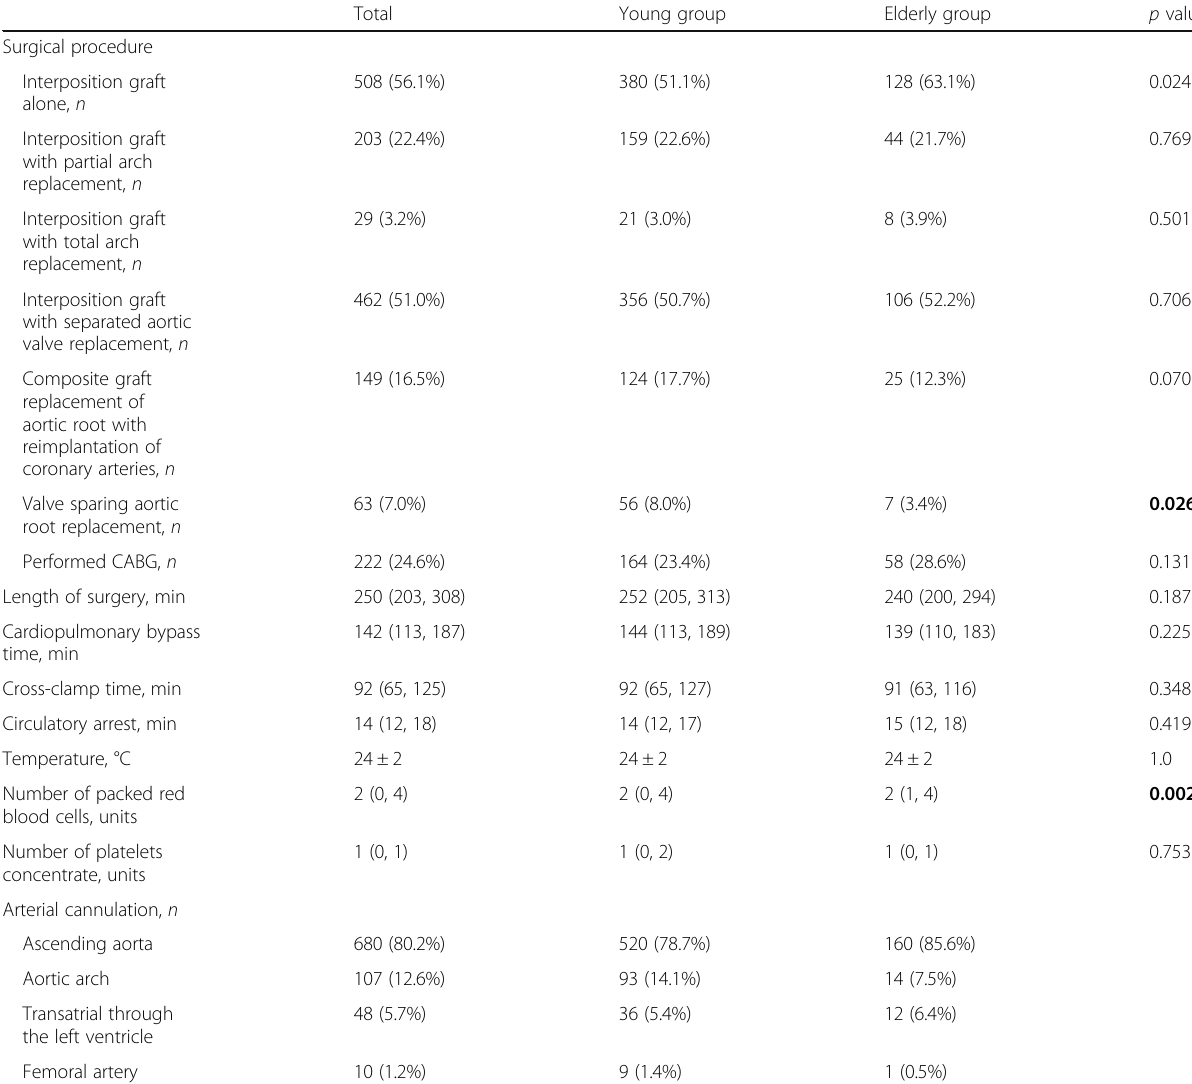
Table 2 Intraoperative course Surgical